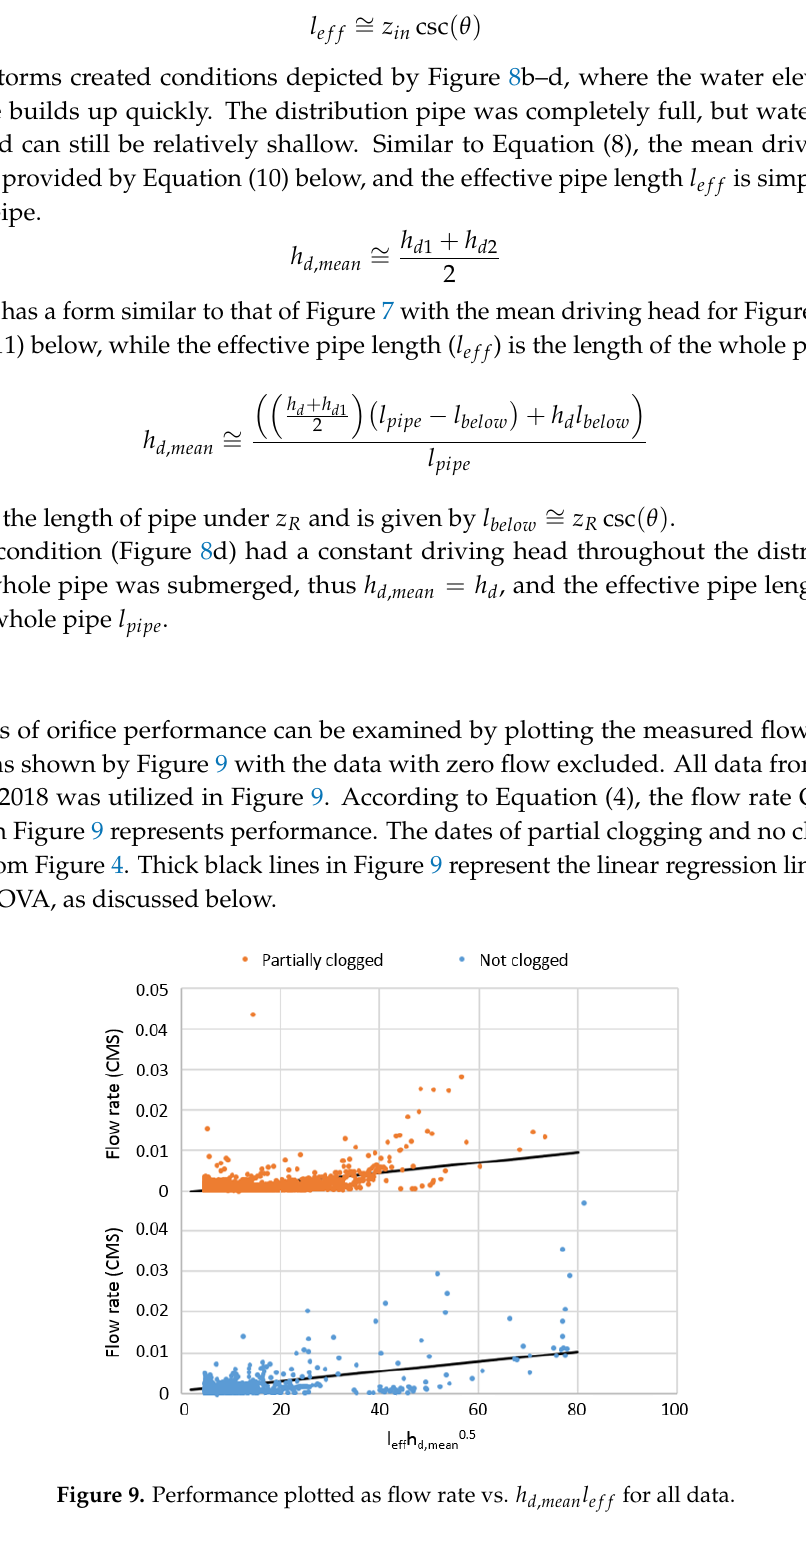
d , mean l ef f for all